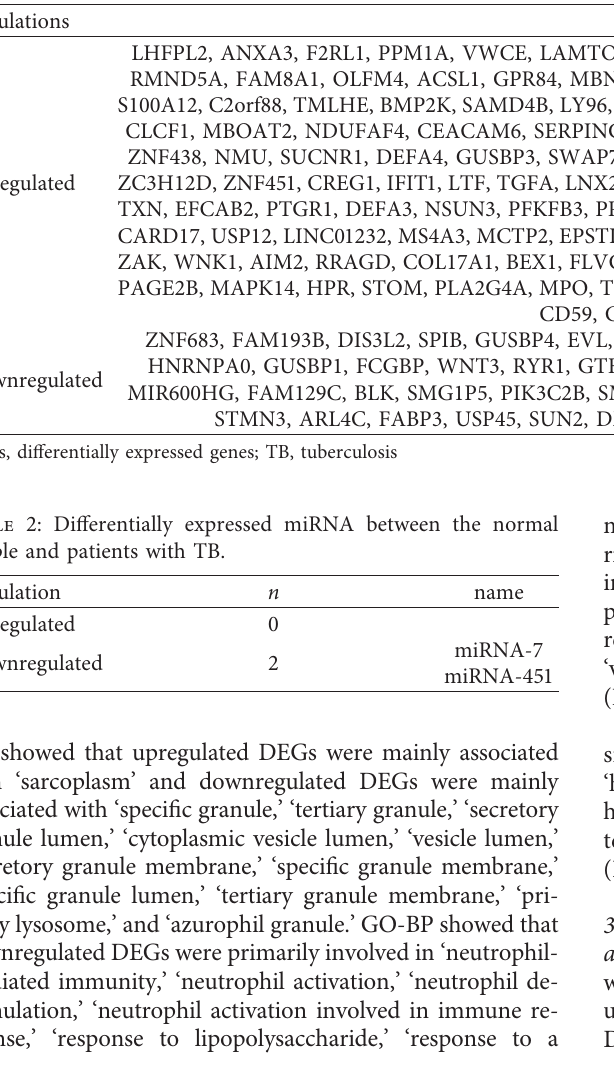
Figure 2: (a) Volcano plot showing downregulated and upregulated differentially expressed genes. (b) Venn diagram displaying the number of common differentially expressed genes (DEGs) between normal people and patients with TB. (c) Venn diagram for common differentially expressed miRNA (DE miRNA). Table 1: Differentially expressed genes between the normal people and patients with TB.